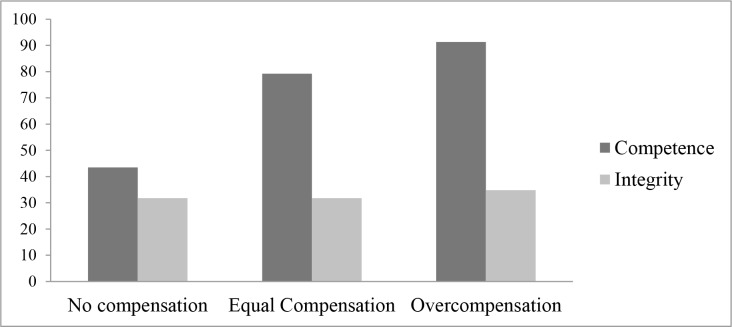
Percentage of participants who chose to complete the next task with Player A as a function of violation type and compensation size.